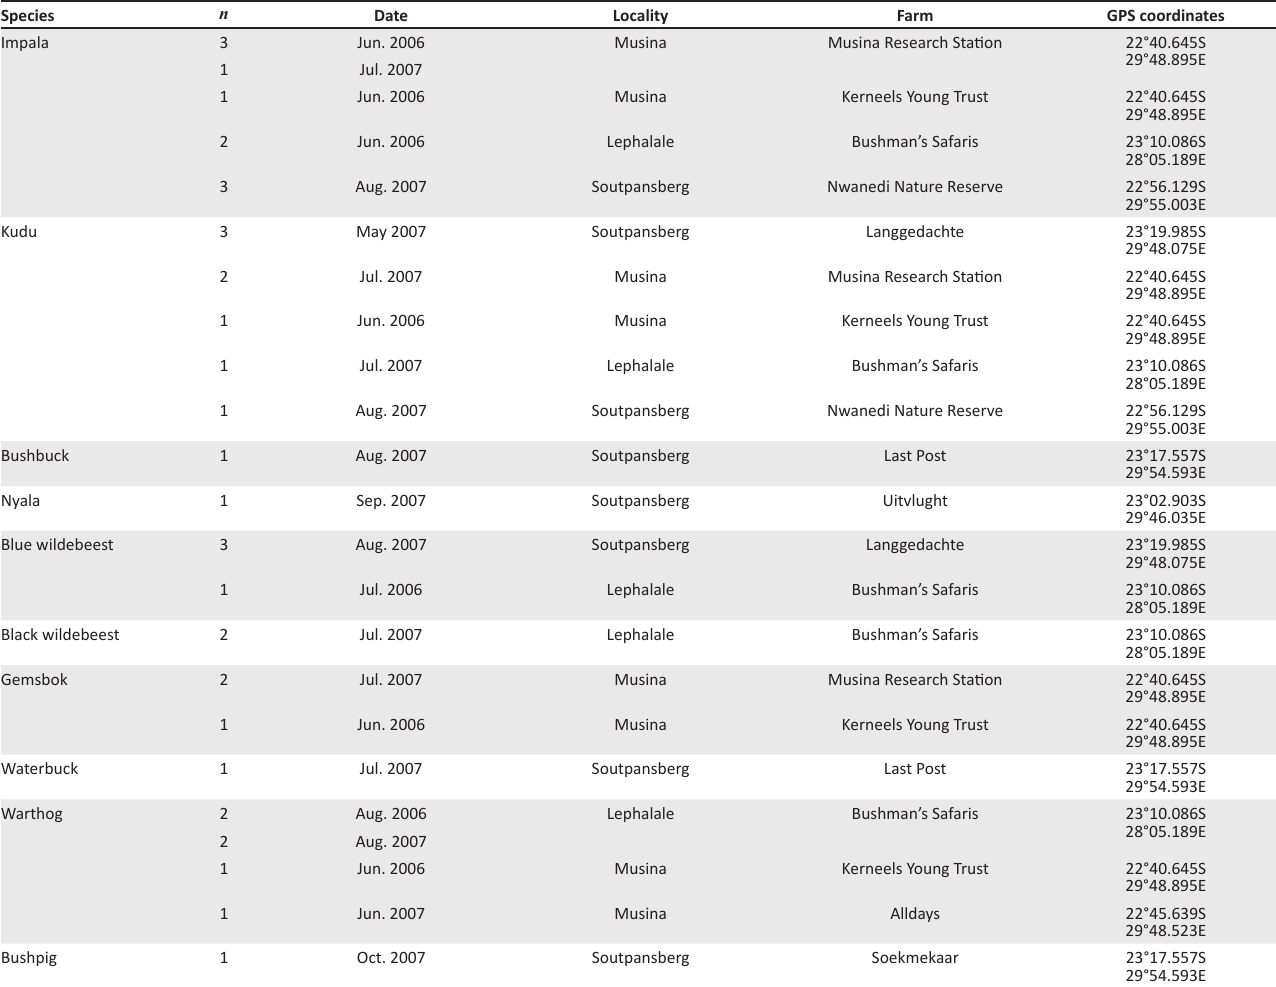
TABLE 1: The collection data for the various animals examined.